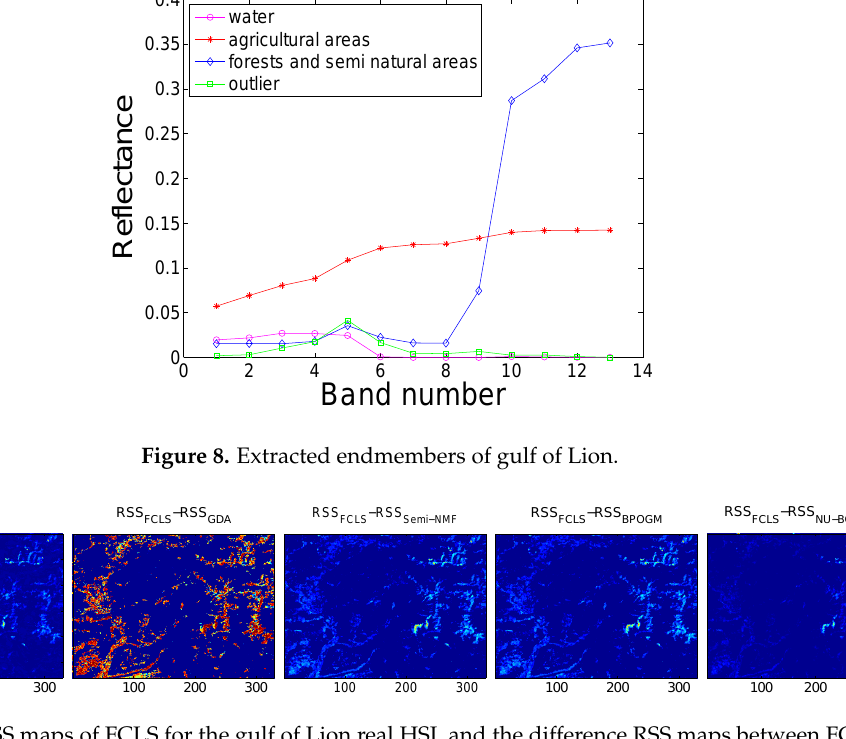
Figure 9. RSS maps of FCLS for the gulf of Lion real HSI, and the difference RSS maps between FCLS and GDA, semi-NMF, BPOGM, and NU-BGBM